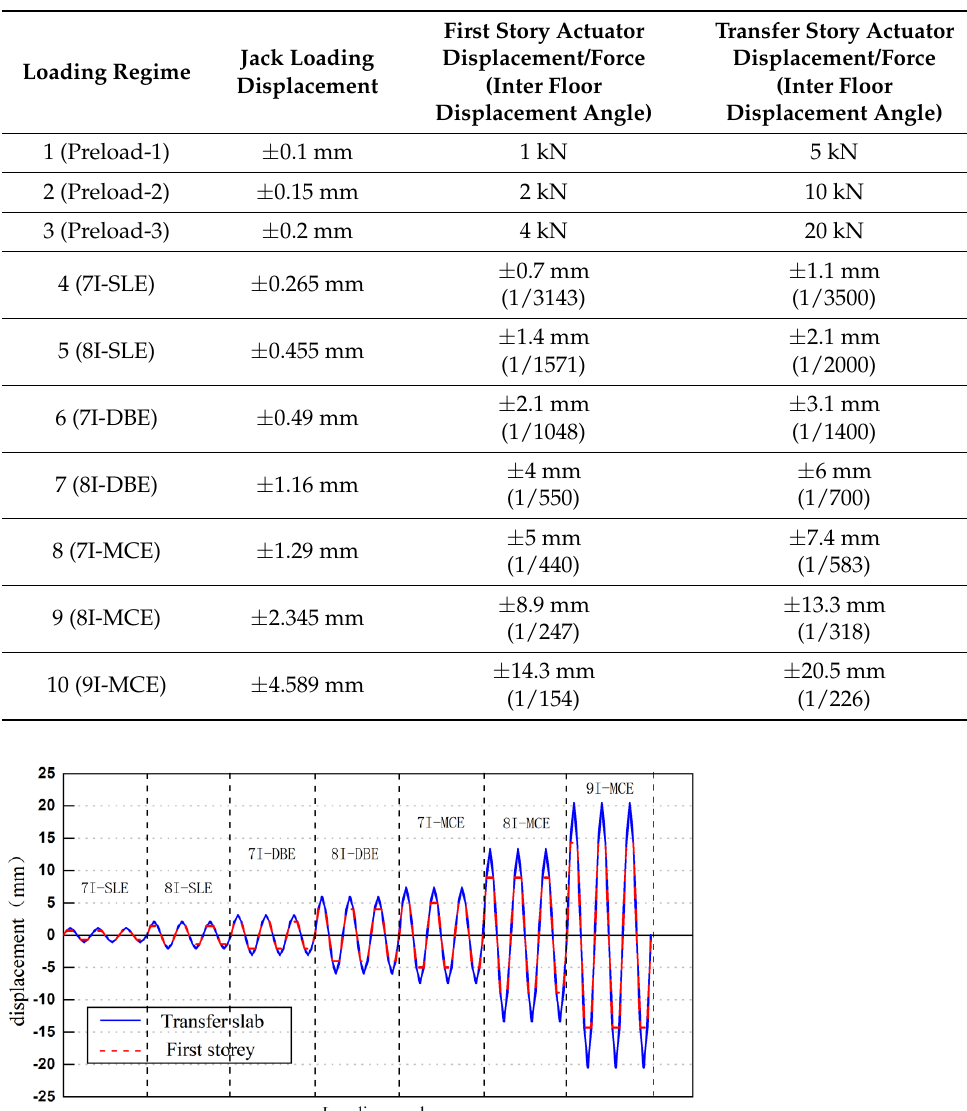
Table 4. Load regime.